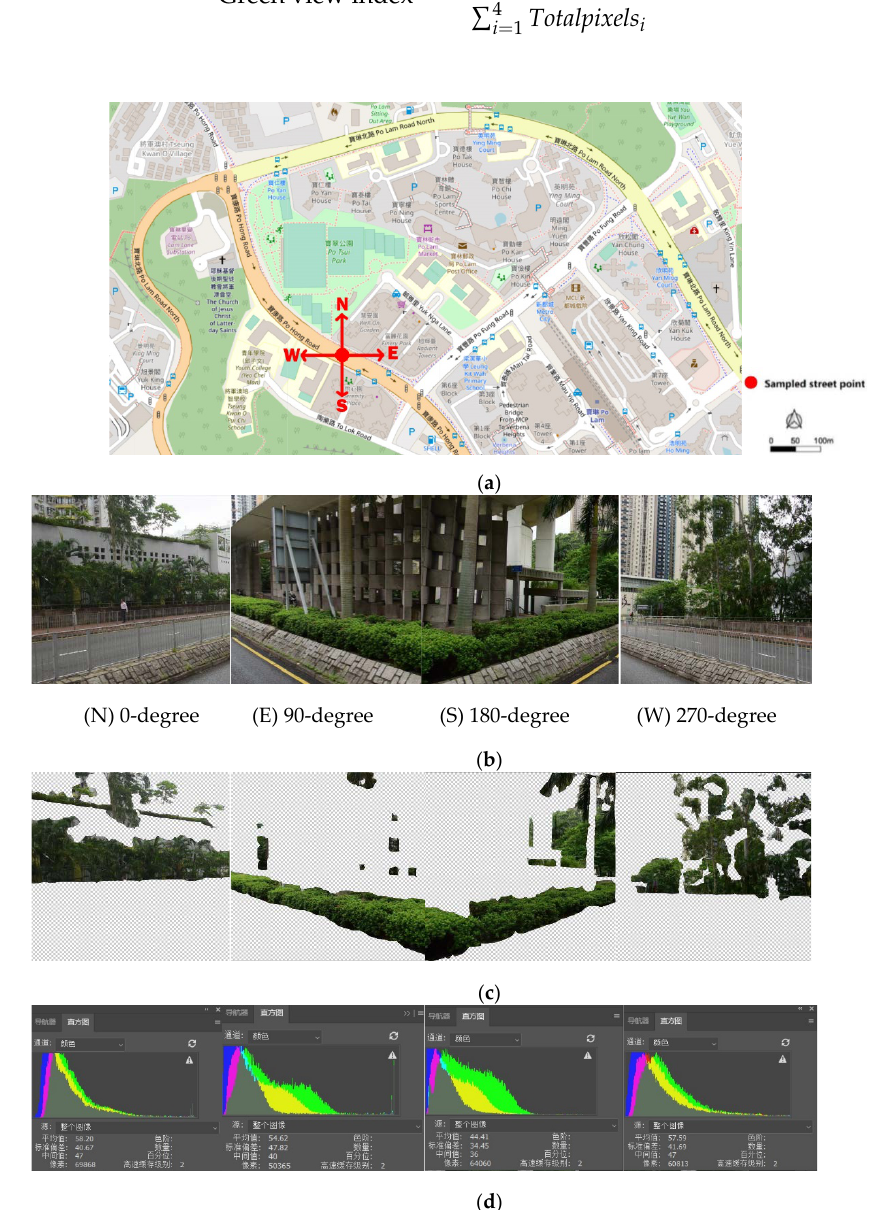
Figure 2. Eye-level street greenery assessment. ( a ) Sampling points with 50 m spacing were addressed in the street centerlines. ( b ) Four streetscape images were captured for each point from Baidu Street View from directions of north, east, south, and west. ( c ) All vegetation in a photo was extracted in Adobe Photoshop. ( d ) The total number of pixels representing vegetation were calculated with a histogram.